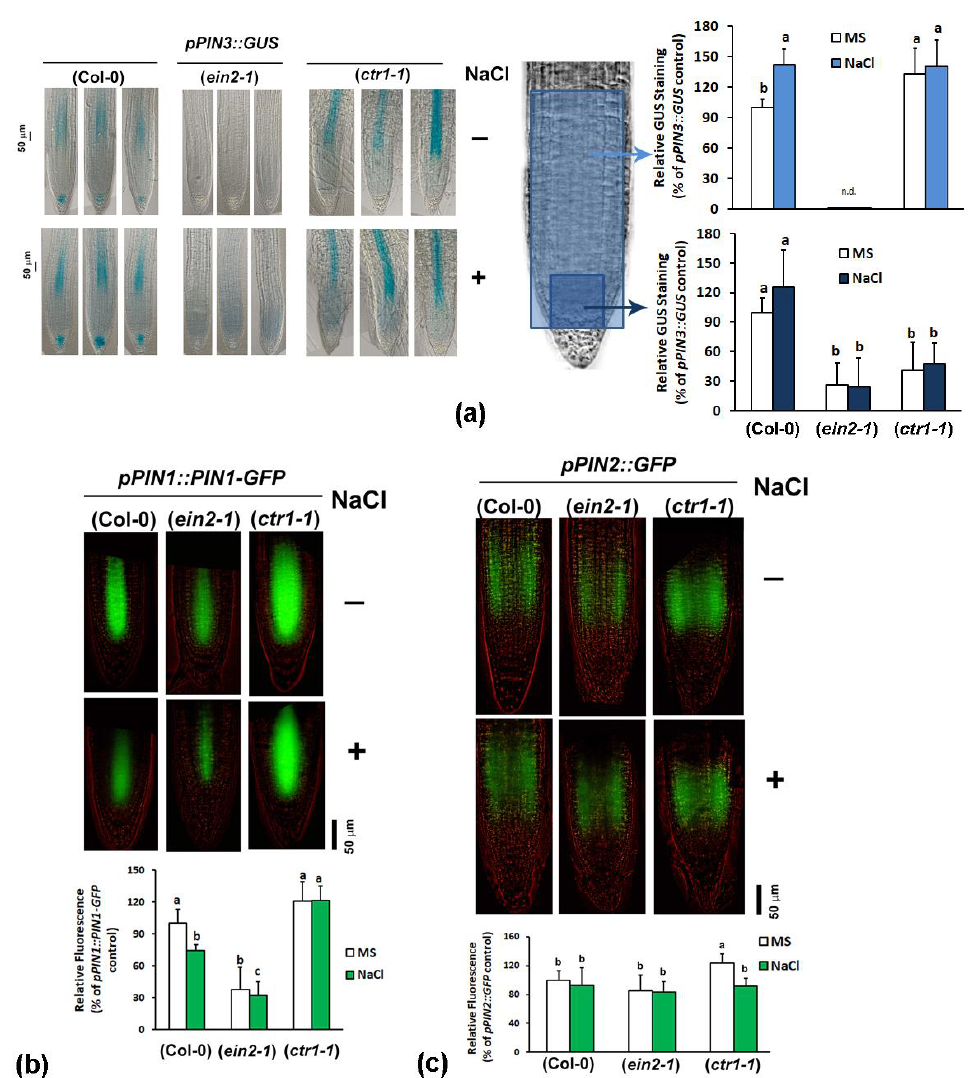
Figure 6. Auxin efflux carrier expression in ethylene-signaling mutants subjected to treatment with 100 mM NaCl for 48 h: ( a ) GUS staining patterns and staining intensity measurement in roots of wild type Col-0 and homozygous F3 mutant ctr1-1 and ein2-1 plants carrying pPIN3::GUS (“n.d.” in the graph means “not detected”). Three representative root images per line and per treatment are shown to demonstrate the consistency of the identified staining differences. The ‘whole frame’ and ‘root meristem’ macros used for the measurements are marked with light and dark blue, respectively. ( b ) Fluorescent intensity measurements (whole frame) in roots of pPIN1::PIN1-GFP reporters and their crosses with ctr1-1 and ein2-1 (homozygous F3 plants). ( c ) Fluorescent intensity measurements (whole frame) in roots of pPIN2::PIN2-GFP reporters and their crosses with ctr1-1 and ein2-1 (homozygous F3 plants). The letters in the graphs reflect significant differences in the different treatment groups which were found by comparison to the wild type background control. (One-way ANOVA, p ≤ 0.05, and n ≥ 3 datasets from independent crosses).